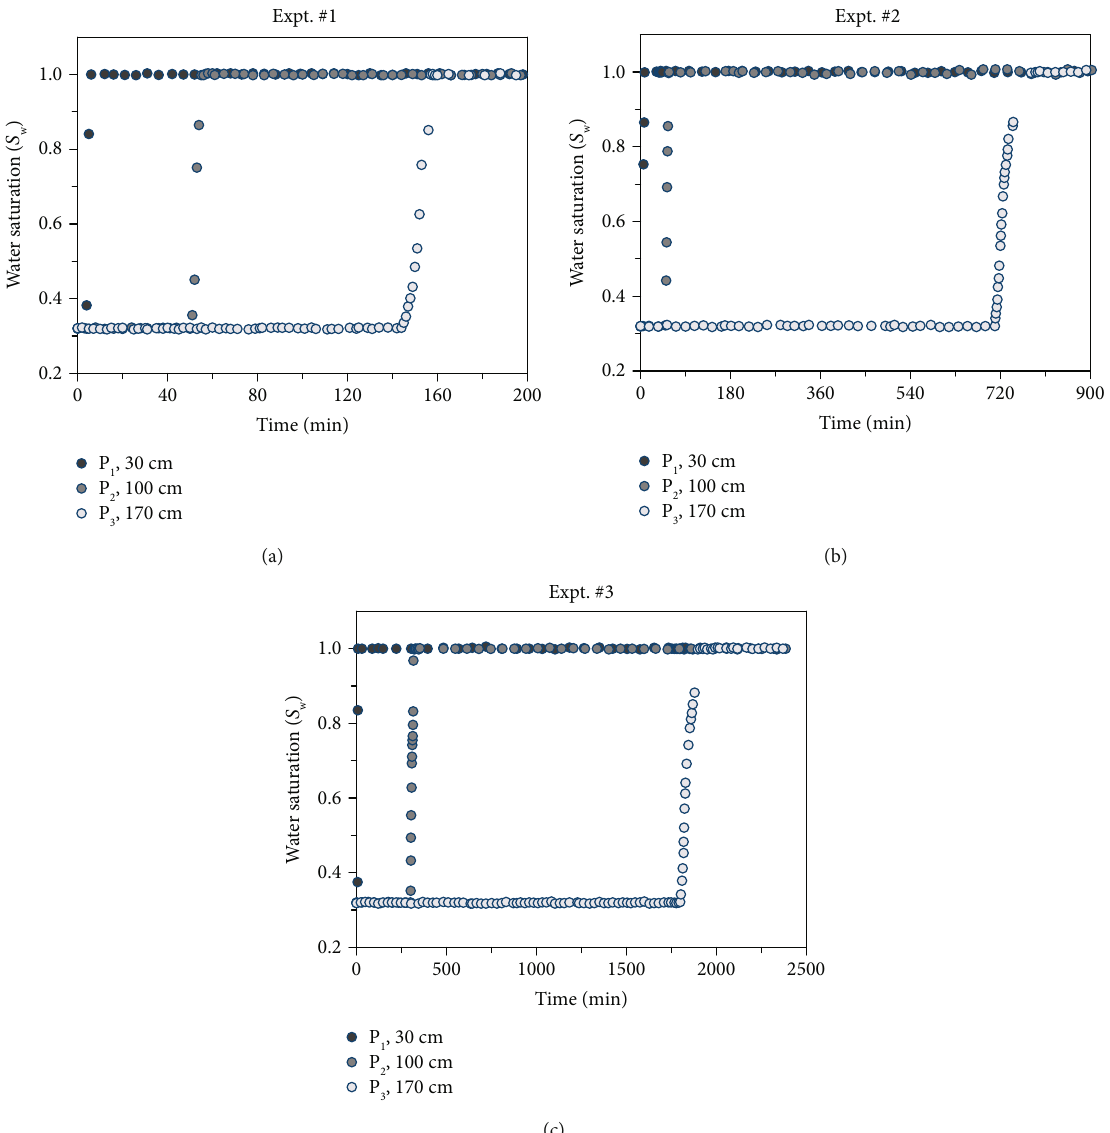
Figure 3: The time evolution of water saturation at selected points P